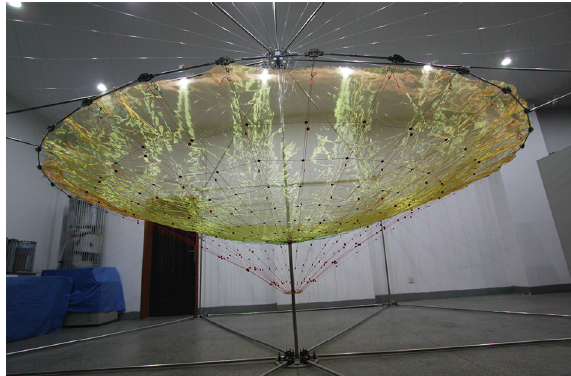
Figure 3: Preliminary physical model of the CMMR.